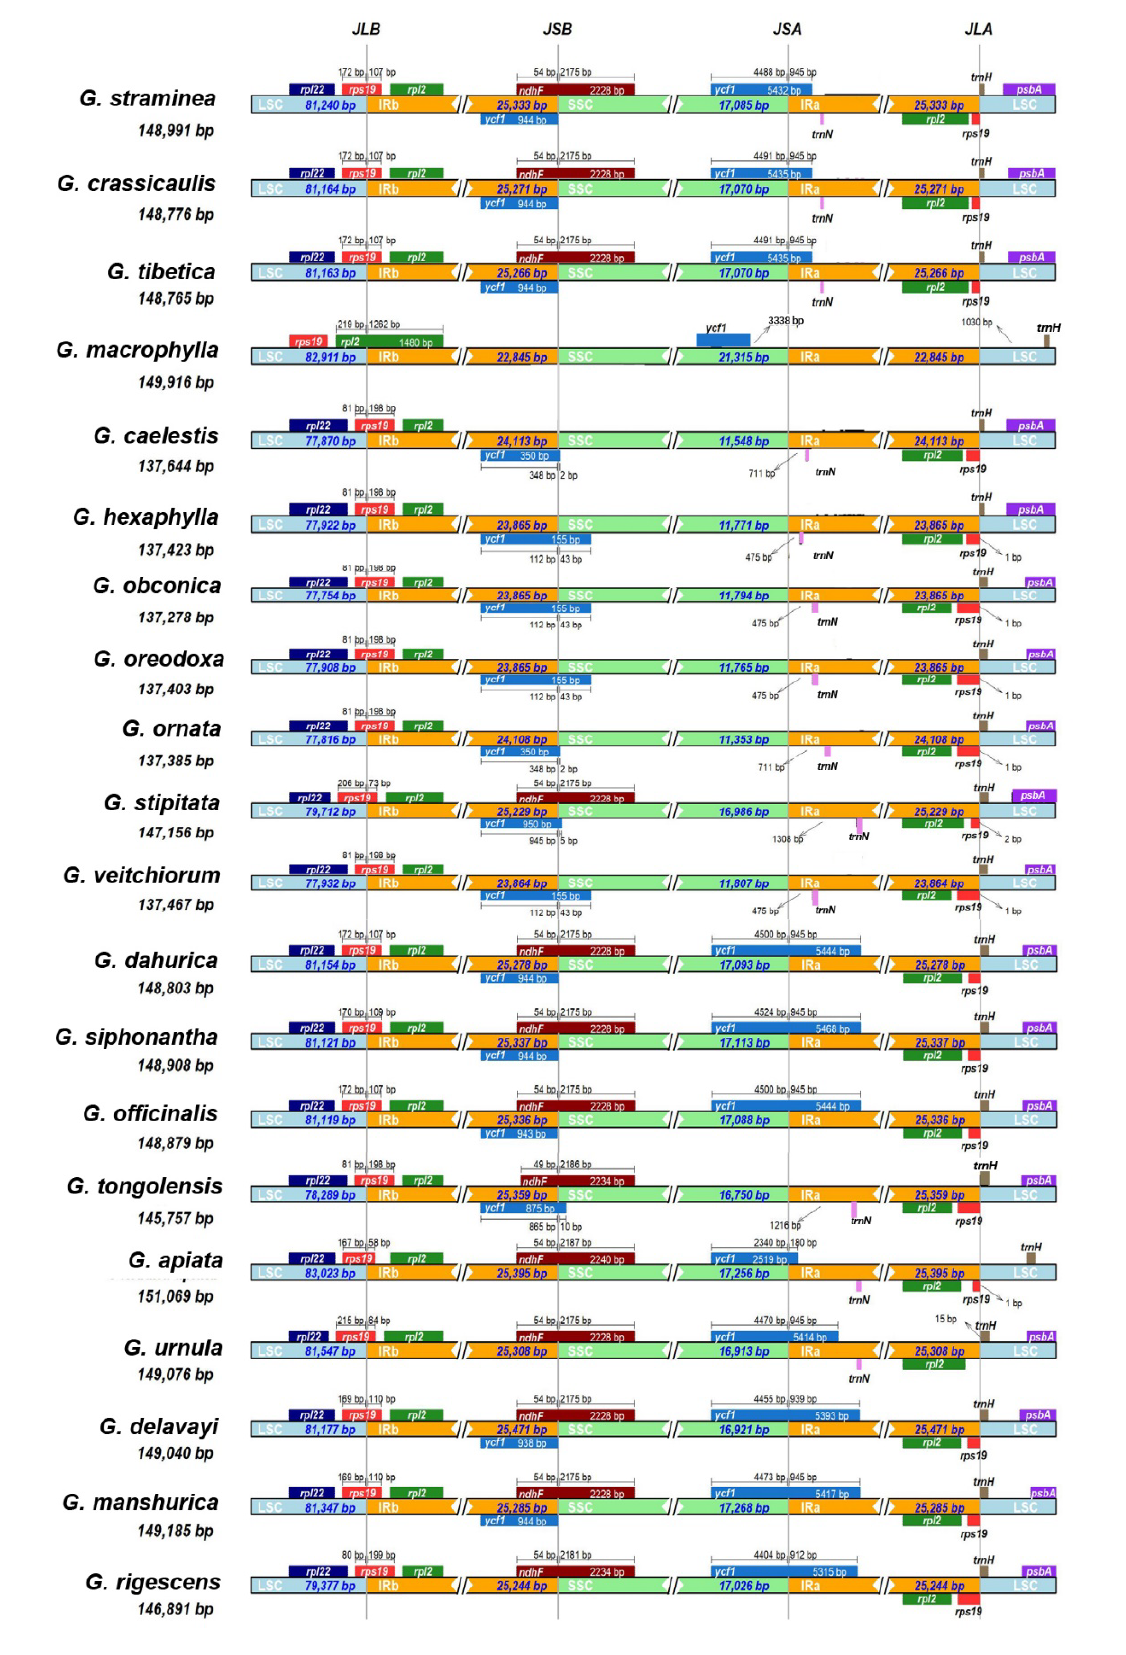
Fig. 4: Comparison of the borders among the LSC, SSC, and IR regions of Gentiana . JLB, JSB, JSA, and JLA indicate junction sites of LSC/IRb, IRb/SSC, SSC/IRa, and IRa/LSC, respectively. The genes around the borders are shown above or below the main line. Light blue color refers to LSC region, light green color refers to SSC region, and saffron yellow refers to a pair of IR